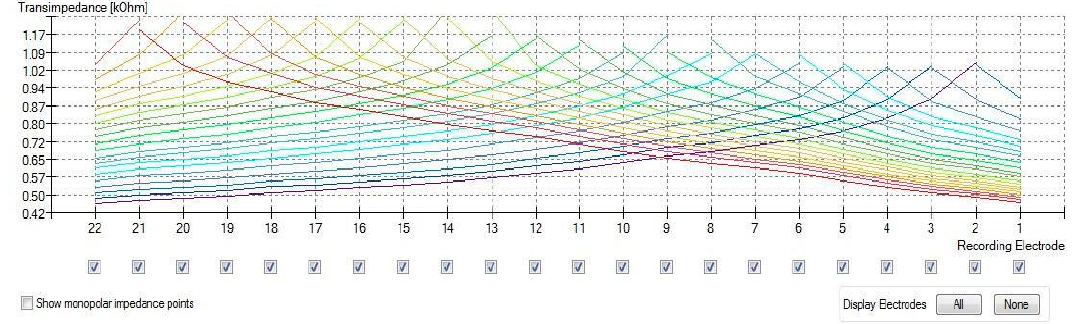
Figure 1. TransImpedance Matrix (TIM) presented on a heat map. In the normal position of the slim perimodiolar electrode, the intracochlear voltage dropped monotonically as the distance between stimulation and recording contact increased, both toward the apex and toward the base.